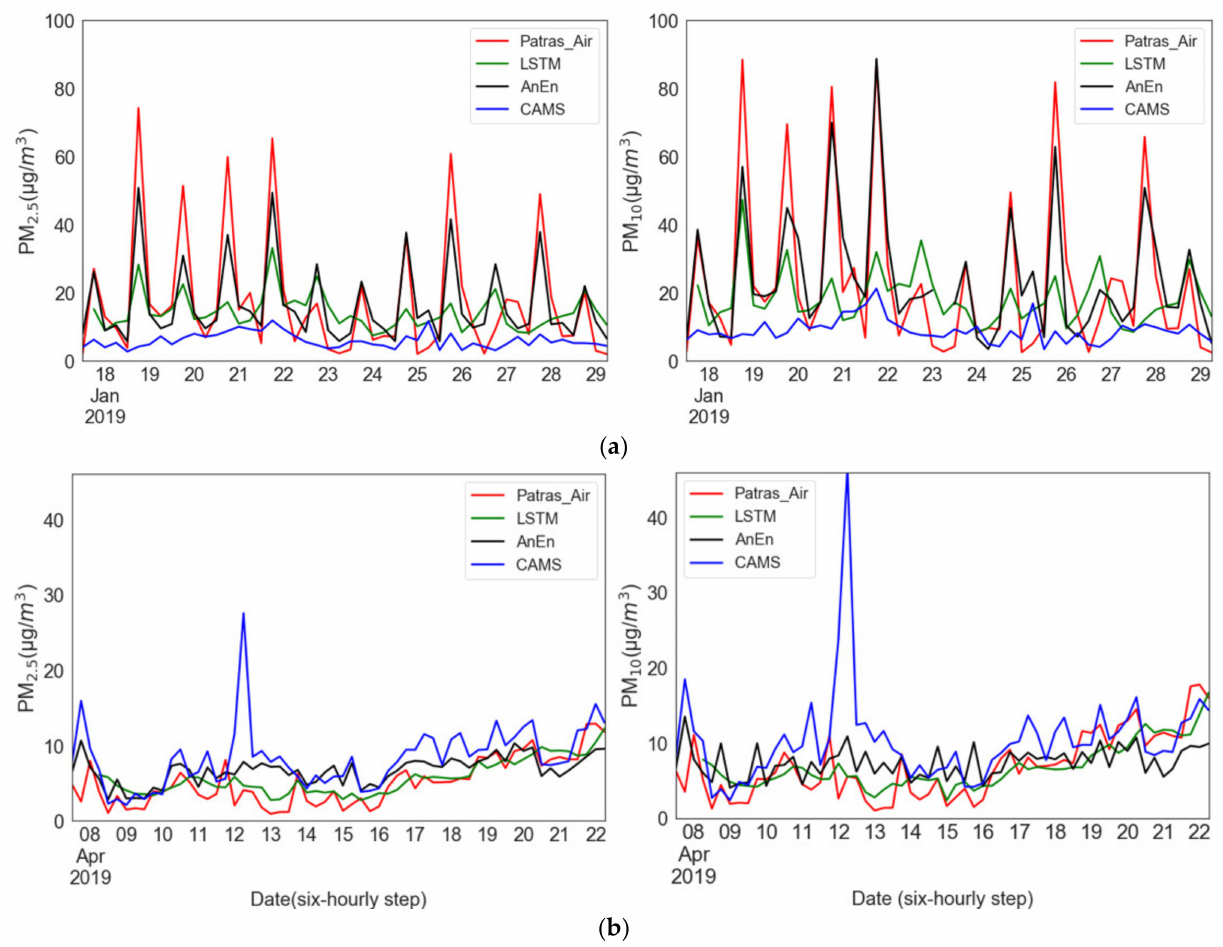
Figure 6. Six-hour time series of PM concentrations with the corresponding models’ predictions over the Patras Air sites for each forecast lead time for a two-week period: ( a ) 17–31 January at Psila Alonia, ( b ) 8–22 April at University of Patras for PM 2.5 (left) and PM 10 (right).